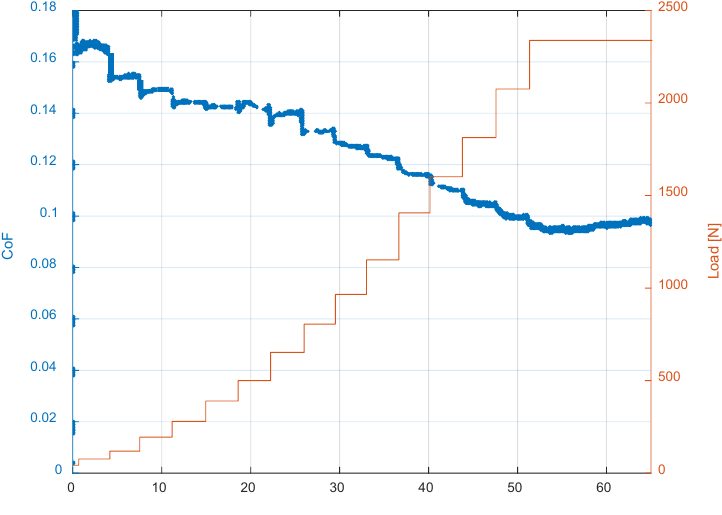
Figure 6. Case 2: Figure 6. Case 2: example. Figure 6. Case 2: example.